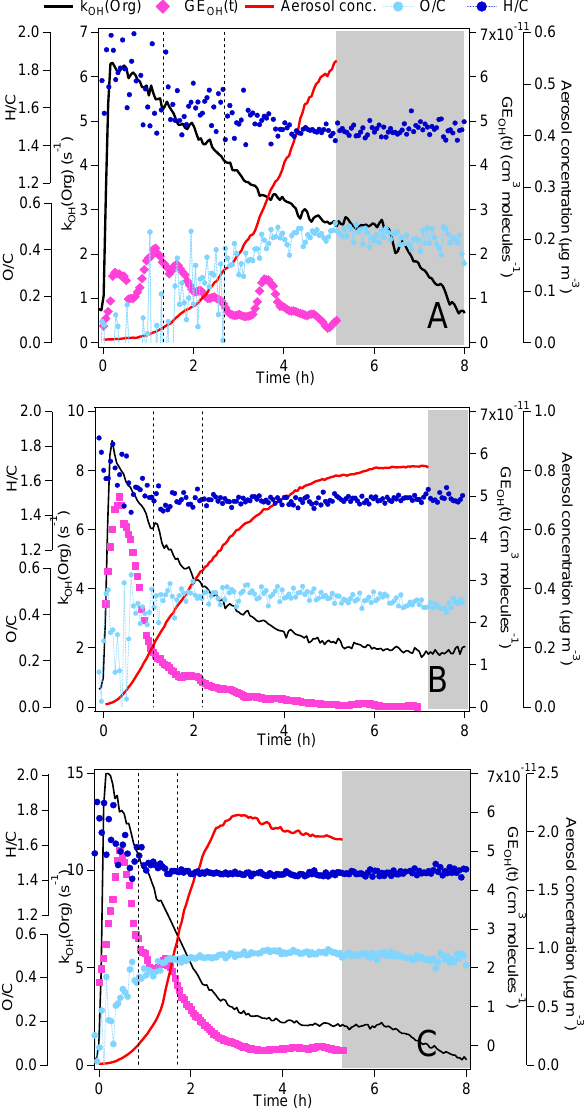
Figure 2. Particle mass concentration and median diameter as a function of OH dose for the OH oxidation of α -pinene (a) , β -pinene (b) and limonene (c) . The dashed vertical lines correspond to the one and two lifetimes of each monoterpene with respect to OH oxi- dation. The lifetime is the time when the monoterpene concentration decreases to 1 / e of the initial concentration.